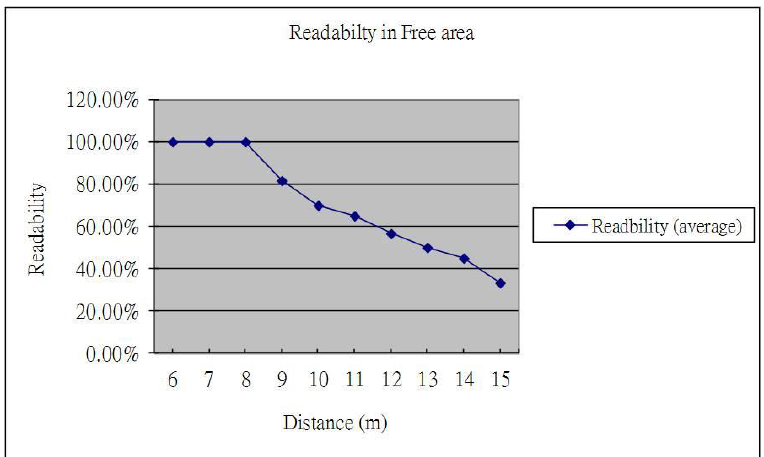
Figure 11. Readability in free area between the range of 6-15m